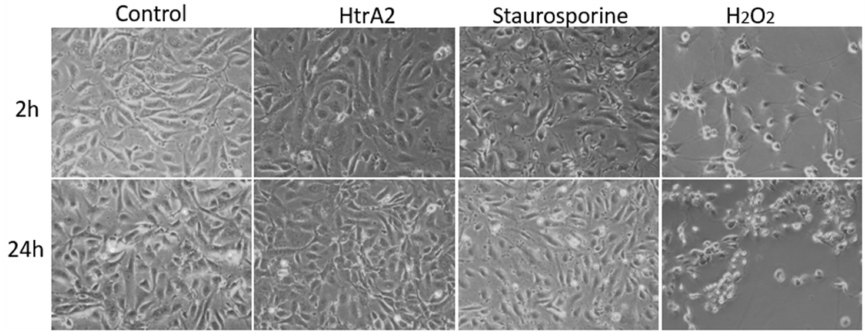
Figure 3. Morphology of HUVEC treated with HtrA2, staurosporine, H 2 O 2 or untreated control. Morphology is visualised under microscope (magnification, 40 ×